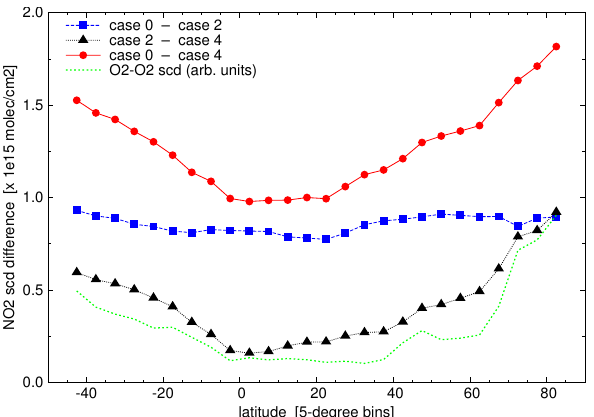
Figure 5. Absolute values of the updated data (case 4, top row) Fig. 5. Absolute values of the updated data (case 4, top row) and absolute differences between the current and the updated data (bottom row) of the orbit average RMS error (left column, × 10 − 4 ) and NO 2 SCD (right and absolute differences between the current and the updated data column, × 10 15 molec/cm 2 )asfunctionoftheOMIorbitnumberon4selecteddays. Thecasenumbersreferto (bottom row) of the orbit average RMS error (left column, × 10 − 4 ) thecaseslistedinTable4. Measurementsfromtherowsaffectedbytherowanomalyinthe2013(rows25-48 and NO 2 SCD (right column, × 10 15 moleccm − 2 ) as a function of and53)havebeenomittedfromalldatainthiscomparison. the OMI orbit number on 4 selected days. The case numbers refer to the cases listed in Table 4. Measurements from the rows affected by the row anomaly in the 2013 (rows 25–48 and 53) have been omitted from all data in this